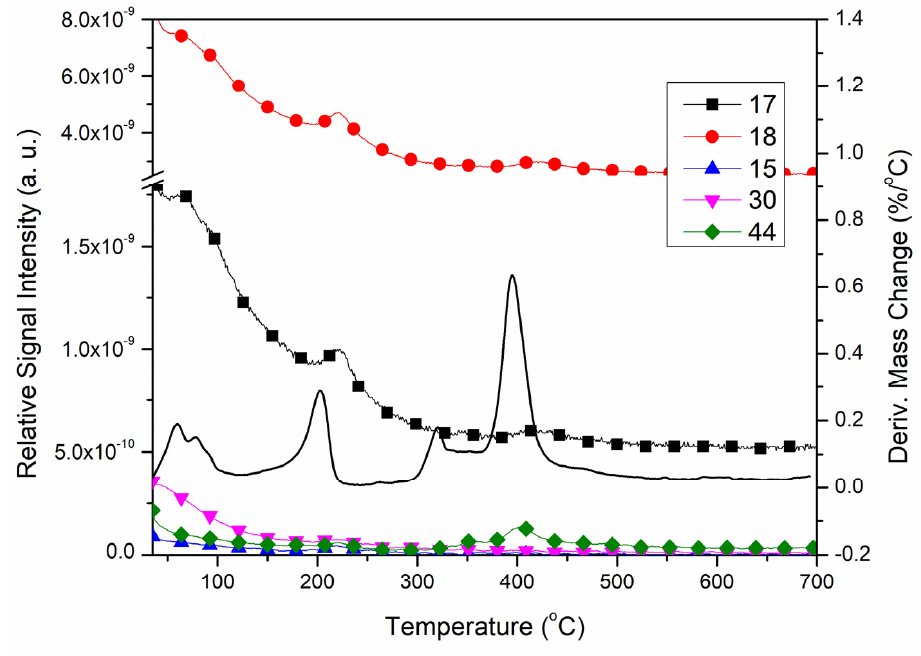
Figure 8. TG–MS signals of fragments evolved from 2 during heating in argon.